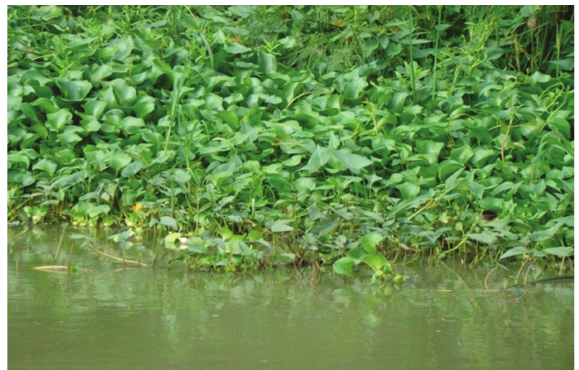
Figure 3: Water hyacinth mat showing encroachment by Ipomoea aquatica and Enydra fluctuans .